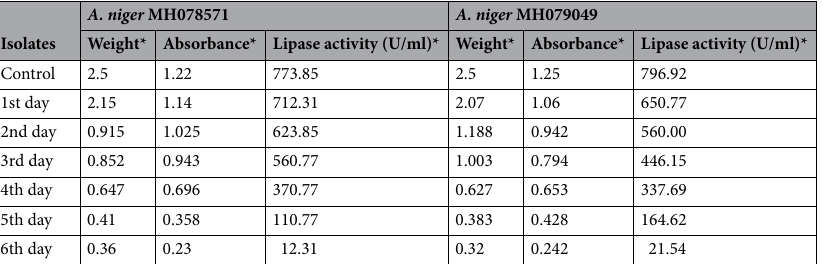
Table 3. The determination of lipase efficiency and activity of both A. niger isolates in degrading sheep fat. *Averages of three replicates.